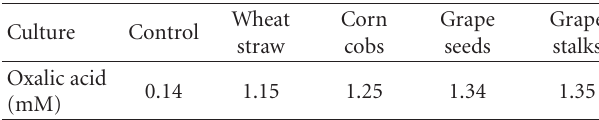
Table 2: Oxalic acid concentration of cultures of T. versicolor per- formed with several lignocellulosic